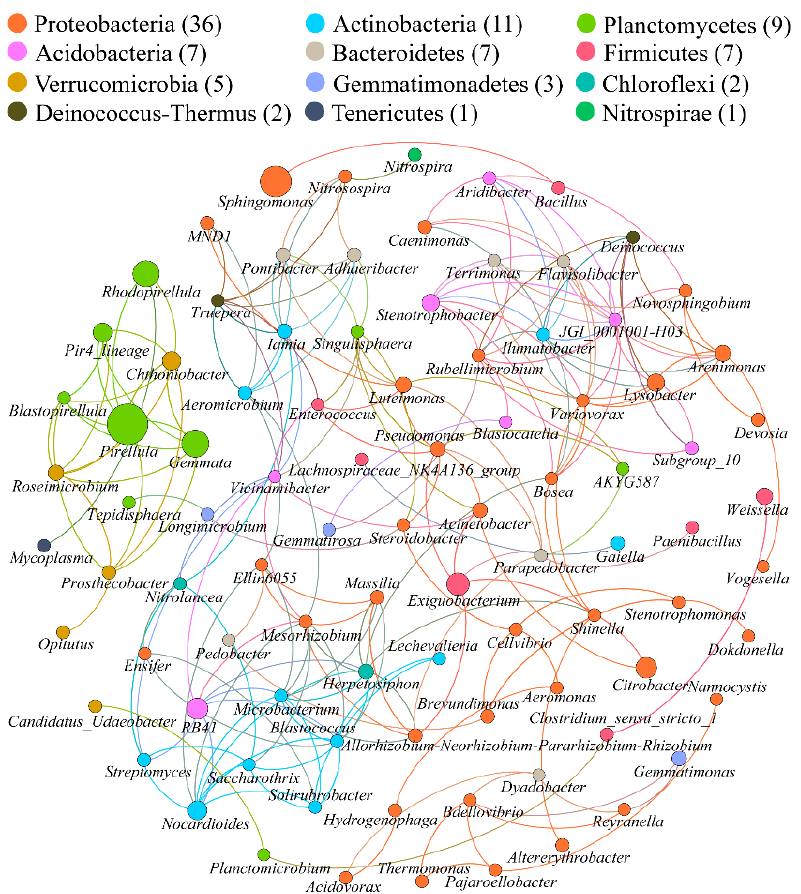
Figure 6. Network of co-occurring bacterial genera in ionic cerium treatments based on Spearman correlation analysis sorted in color by phylum. A connection indicates a significant ( r > 0.6, p < 0.01) correlation. The size of each node (genus) is proportional to its abundance.